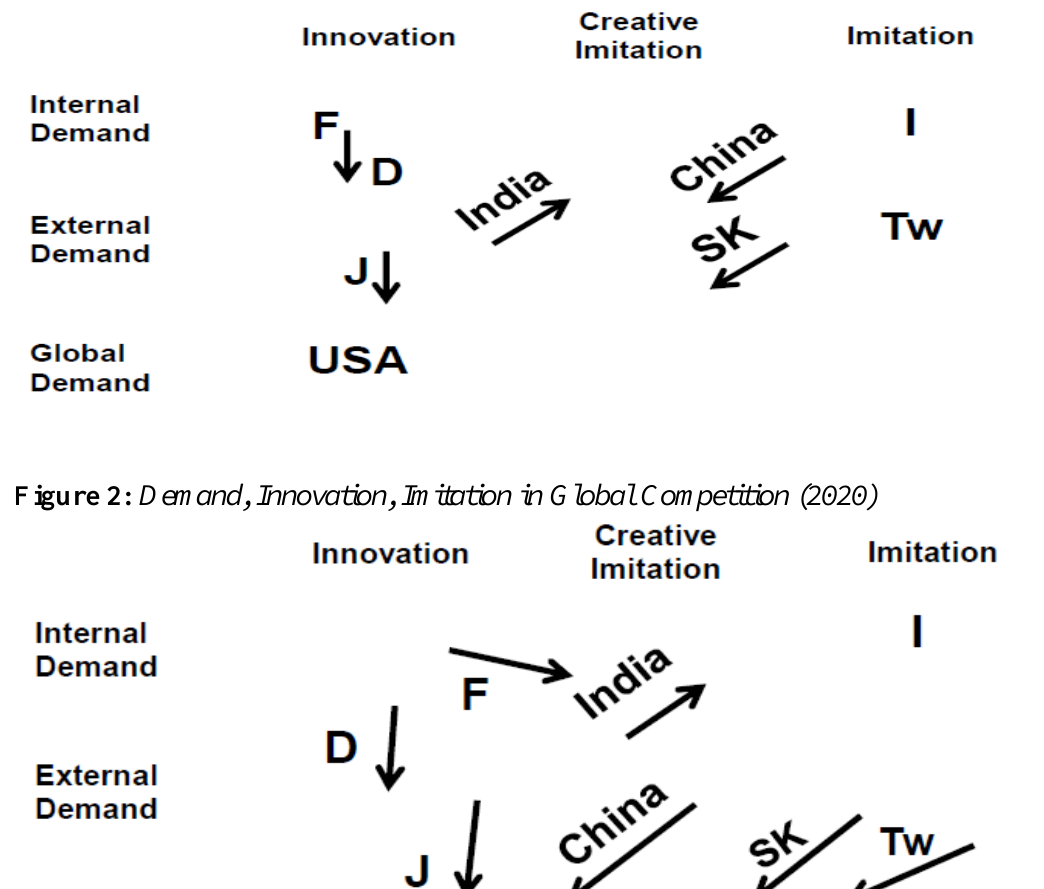
Figure 1: Demand, Innovation, Imitation in Global Competition (2013)